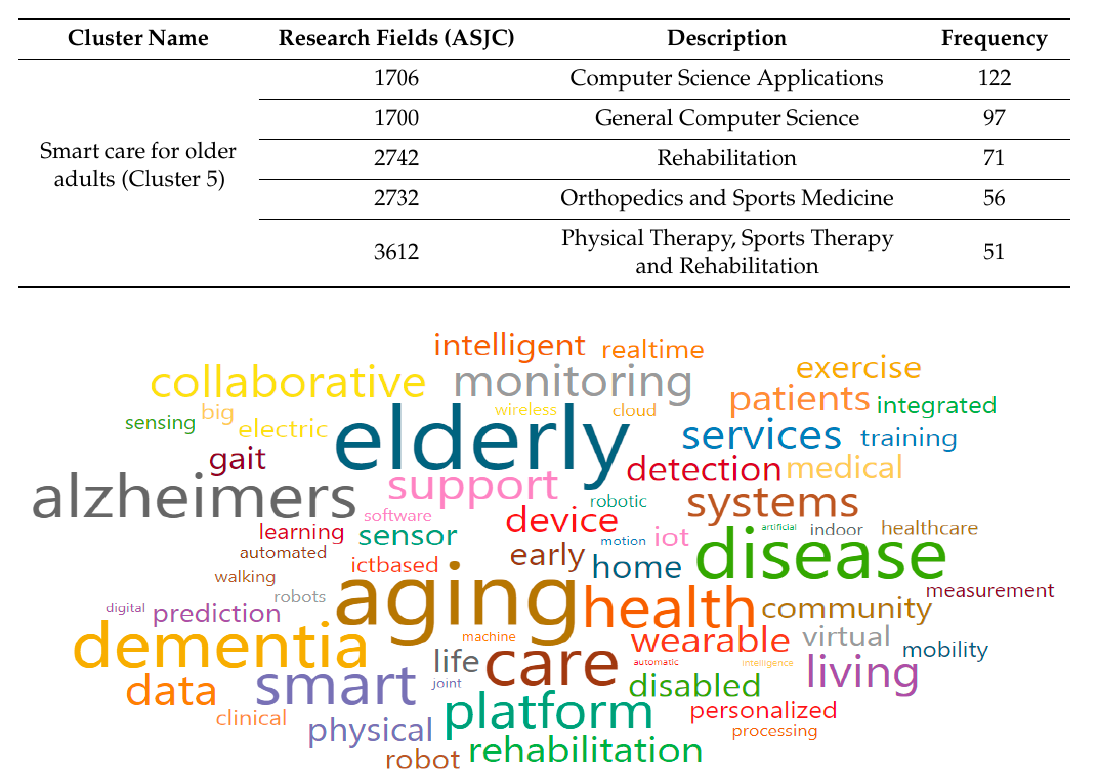
Table 6. Major research fields in Smart care for older adults (Cluster 5).